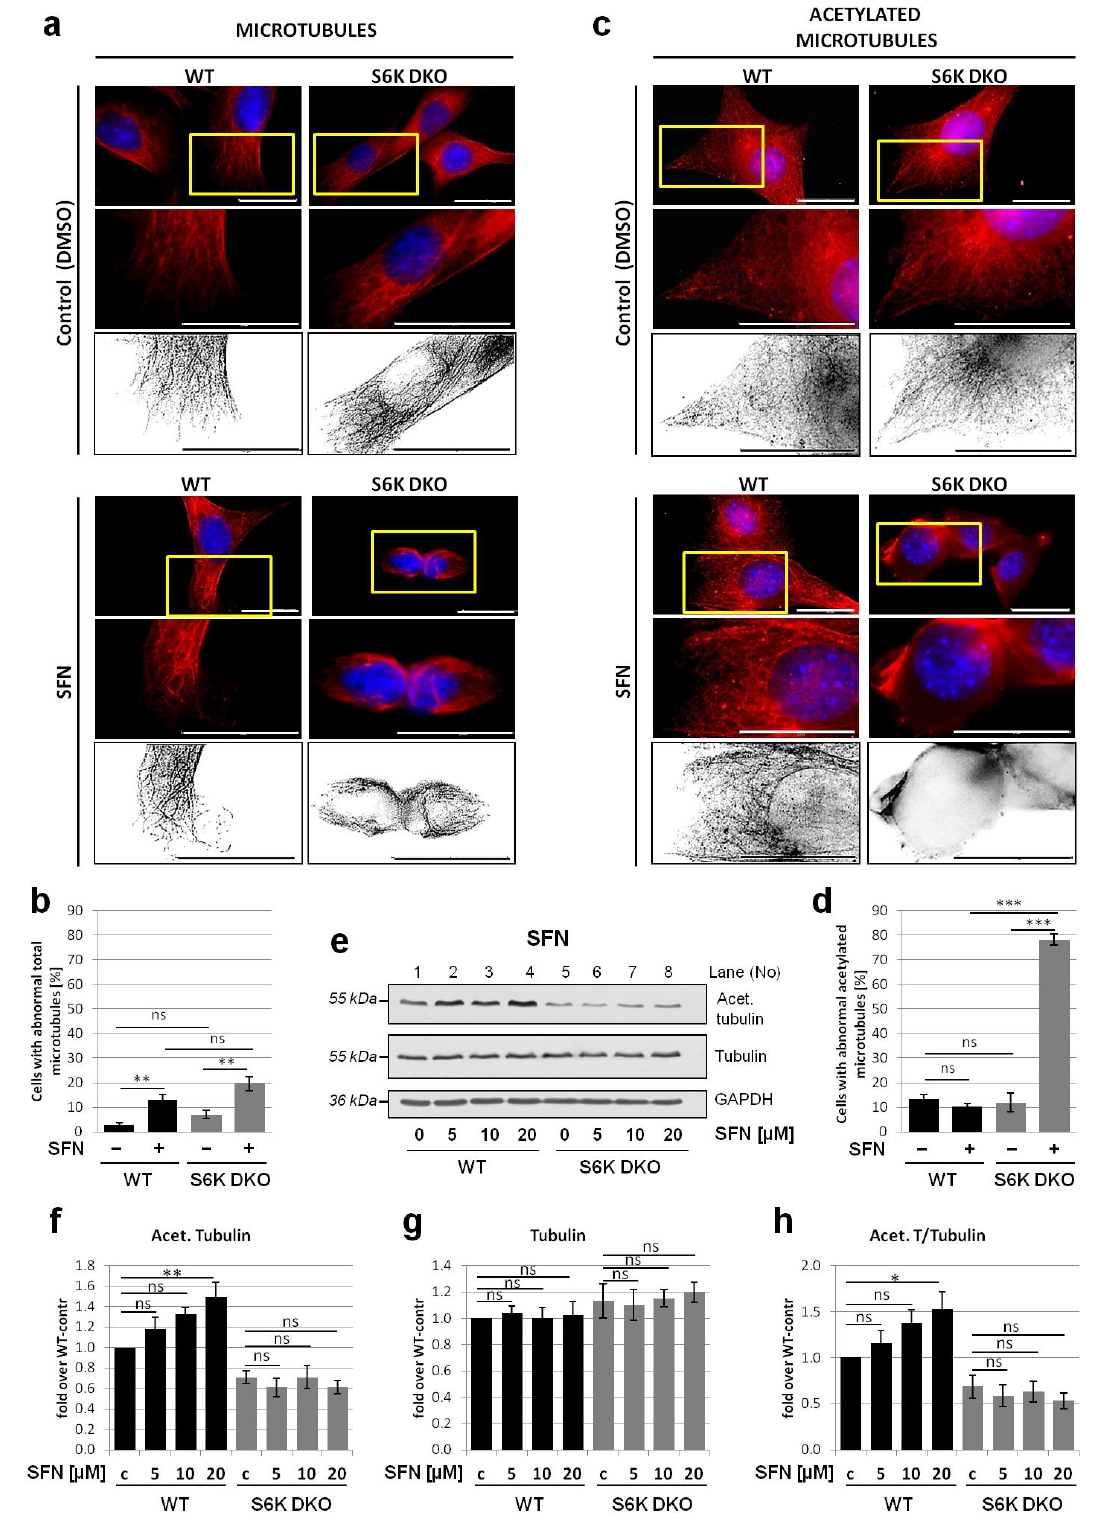
Figure 4. Acetylated microtubules but not the total microtubule network are disrupted in S6K DKO MEF treated with SFN. Total microtubule network ( a,b ) and acetylated microtubule network ( c,d ) were investigated by immunofluorescent staining of total α-tubulin ( a ) or acetylated tubulin ( b ), respectively, in WT and S6K DKO (DKO) MEF treated with 20 µM SFN or DMSO (control) for 6 h. The cells were stained with mouse antibodies against α-tubulin ( a ) or against acetylated tubulin (Lys40) ( b ), followed by staining with goat anti-mouse–TRITC conjugates. DNA was stained with DAPI (blue). The indicated sections of original images are enlarged (middle panels) and, for clarity, deconvoluted and transformed into inverted grey scale (bottom panels). Representative images of cells analyzed in at least 10 random fields per replicate are